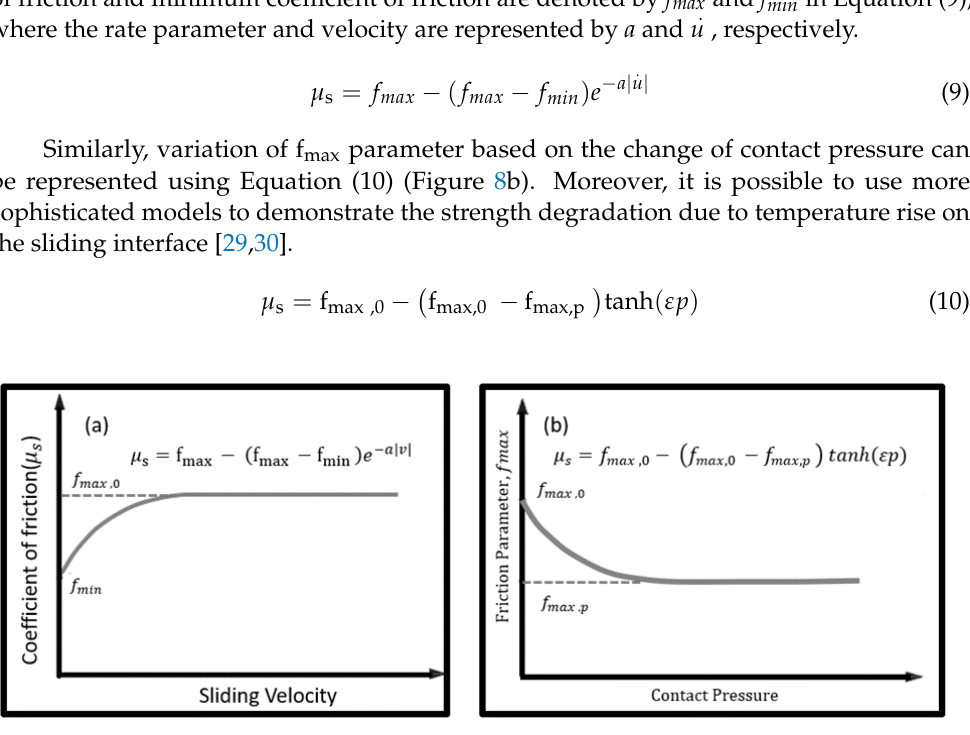
Figure 8. ( a ) Velocity-dependent friction model. ( b ) Maximum coefficient of friction under varying contact pressure [28,31].